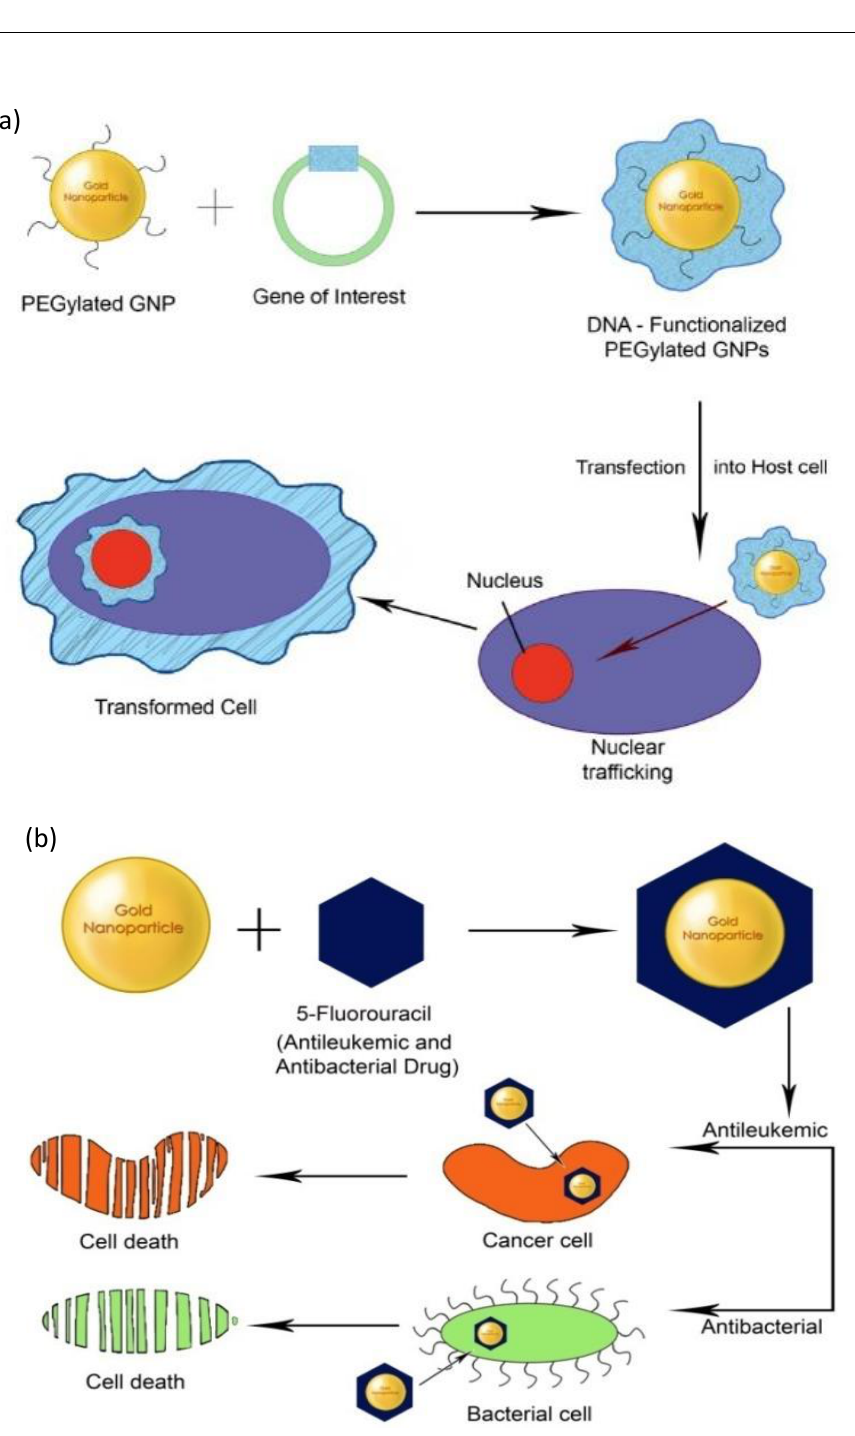
Figure 9. ( a ) PEGylated gold nanoparticles for gene delivery. ( b ) Functionalized gold nanoparticles for drug delivery. Adapted from ref. [70], copyright 2011, with permission from MDPI.